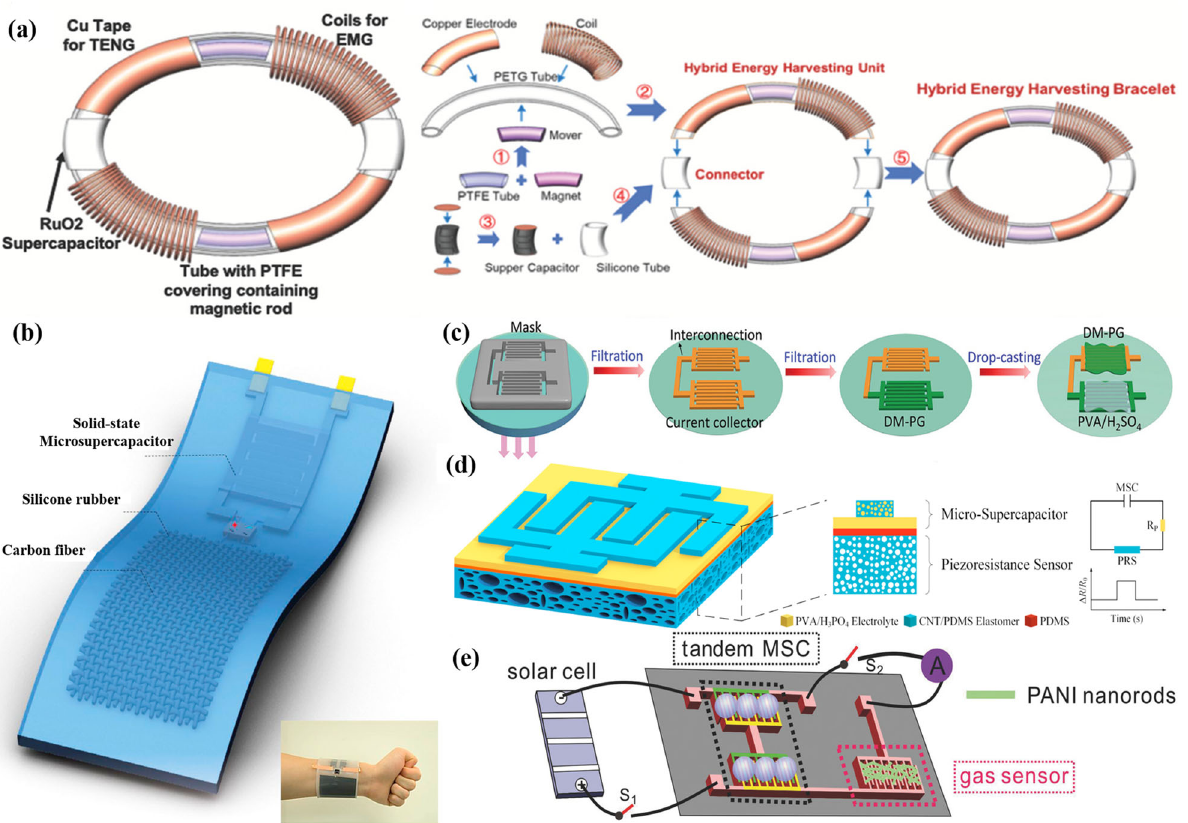
Fig. 6 MSCs for energy storage and sensors integration. a The fabrication process of the hybrid energy harvesting bracelet. b Schematic diagram of the wearable self-charging system device, inset photograph demonstrates that the system worn on the forearm. c Fabrication of the planar MSC-sensor integrated system. d Schematic illustration of all-in-one sensing patch based on the porous CNT-PDMS elastomer. e Schematic of the self-powered integrated device. a Reproduced with permission 126 (Copyright © 2019, John Wiley and Sons). b Reproduced with permission 127 (Copyright © 2018, Elsevier). c Reproduced with permission 131 (Copyright © 2020, John Wiley and Sons). d Reproduced with permission 132 (Copyright © 2018, Elsevier). e Reproduced with permission 135 (Copyright © 2017, John Wiley and